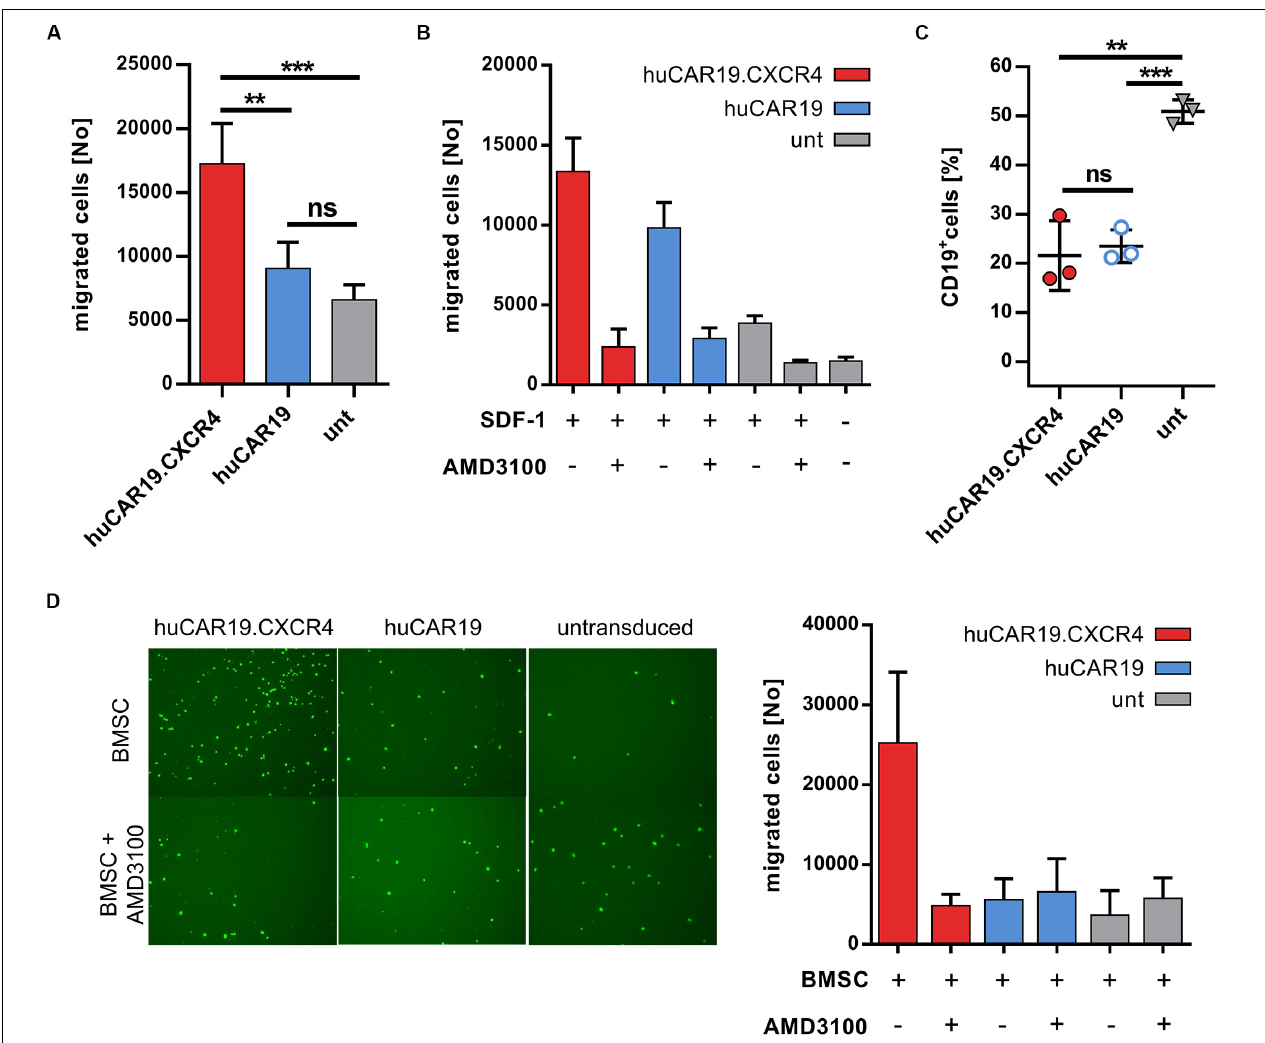
FIGURE 4 | Chemotaxis of NK cells is enhanced by CXCR4 overexpression. The migratory potential of genetically modified NK cells was evaluated in a migration assay using transwell plates. CAR NK cells were generated by transduction of primary NK cells with huCAR19-LV or huCAR19.CXCR4-LV particles. Untransduced primary NK cells cultured in parallel were used as a control. (A) Genetically modified or untransduced NK cells were placed in the upper chamber of the transwell plate and analyzed for their potential to migrate toward a lower chamber containing SDF-1 (CXCL12). The number of migrated NK cells was counted by flow cytometry. n = 4 with technical replicates. (B) Migration potential of NK cells was blocked by the CXCR4 antagonist AMD3100. Untreated or AMD3100 preincubated NK cells were placed in the upper chamber of the transwell plate and analyzed for their potential to migrate in the presence or absence of SDF-1. The number of migrated NK cells was counted by flow cytometry. The experiment was done in technical replicates. (C) A coculture assay was performed (in a 1:1 ratio) with migrated NK cells post chemotaxis to determine their cytotoxic potential. Specific target cell lysis was determined by decrease in the percentage of living CD19-positive cells analyzed by flow cytometry. n = 3. The experiment was done in technical replicates. Bar diagram show mean value, SD, and significance. ** p < 0.005; *** p < 0.001; ns, non-significant by unpaired t test. (D) The migration potential of CSFE-labeled NK cells with or without AMD3100 pretreatment toward BMSCs plated in the lower wells. Representative fluorescent microscopic pictures of migrated, CFSE-labeled NK cells (right) as well as quantitative data by flow cytometry (left) is shown. Bar diagram shows individual results as well as mean values and standard deviation. The experiment was carried out once with purified NK cells from two different